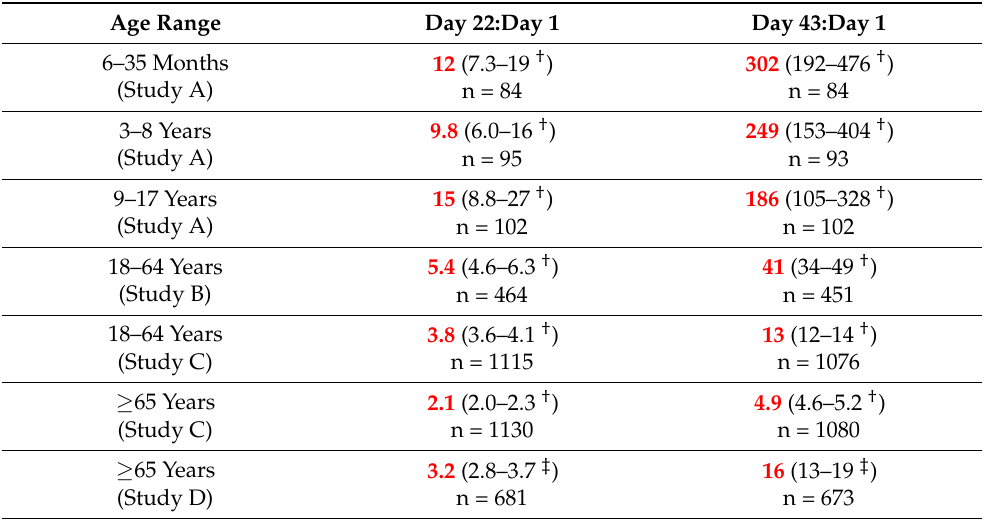
Table 3. Geometric mean ratios (GMRs; 95% † or 97.5% ‡ CI) in response to full-dose formulation, as assessed by hemagglutination inhibition assay three weeks after first dose (Day 22), and three weeks after second dose (Day 43)